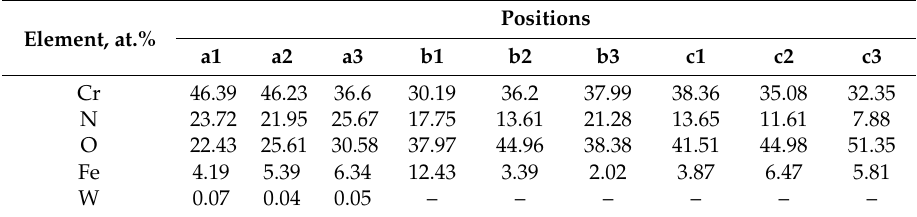
Figure 9. Morphology of the worn tracks on 5 µ m CrN coated M50 disks: ( a ) at the temperature of 315 ◦ C under the load of ( a1 ) 10 N, ( a2 ) 15 N, and ( a3 ) 25 N; ( b ) at the temperature of 400 ◦ C under the load of ( b1 ) 10 N, ( b2 ) 15 N, and ( b3 ) 25 N; and ( c ) at the temperature of 500 ◦ C under the load of ( c1 ) 10 N, ( c2 ) 15 N, and ( c3 ) 25 N. Table 3. The EDS analysis results corresponding to the positions in Figure